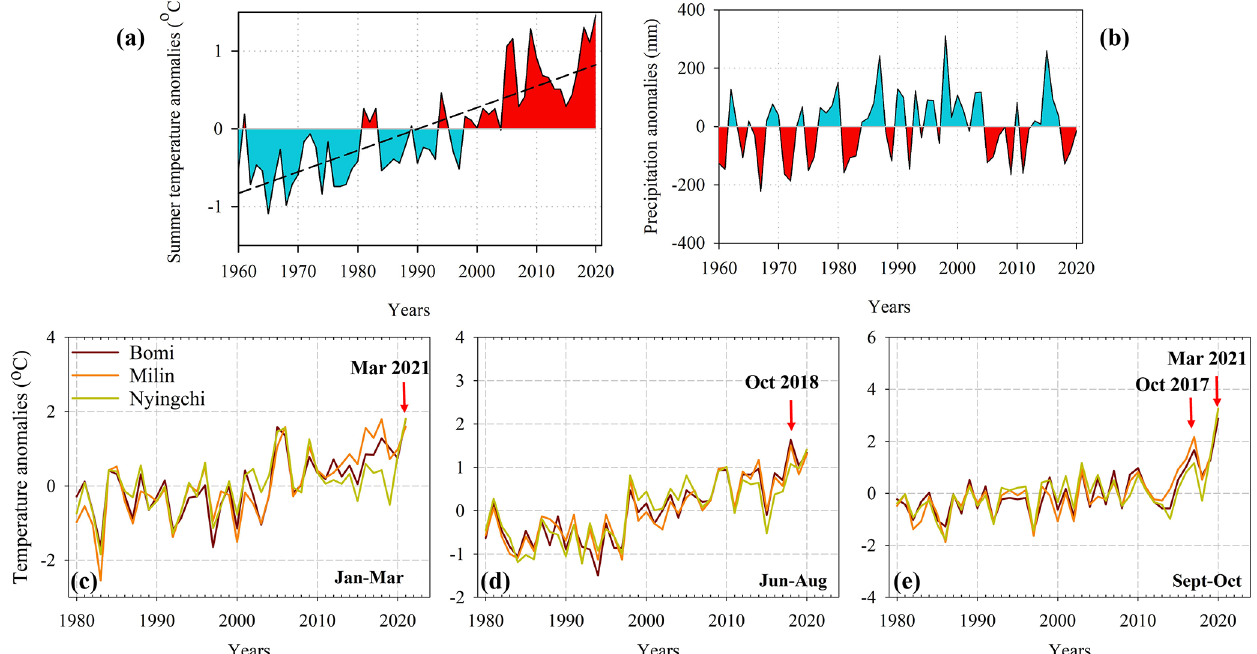
Figure 3. Anomalies of mean air temperature during the ablation season (June–September) and the total annual precipitation at the Nyingchi station, showing the significant air temperature rising (the dashed black line) at the rate of 0.28 ◦ C per decade ( p < 0 . 001) (a, b) . Anomalies of minimum air temperature relative to the mean value for the period 1980–2021, recorded by the three nearest meteorological stations (Bomi, Milin, Nyingchi). The timings of the avalanche events that occurred in October 2017, October 2018, and March 2021 are shown for context (c–e)